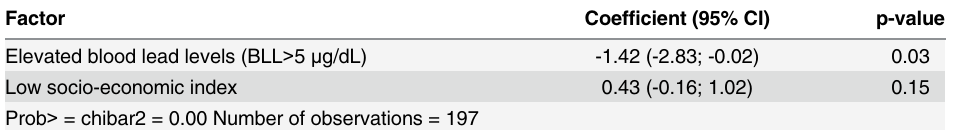
Table 6. Linear regression on factors associated with P . falciparum density at 12 months (logarithm of parasite density at lead